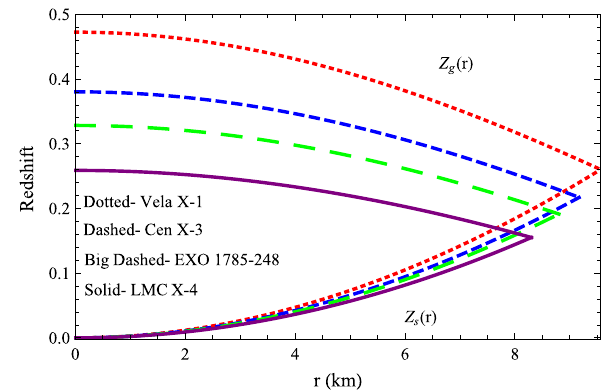
Fig. 6 Functions ρ( r ) − p r ( r ) , ρ( r ) − p t ( r ) and ρ( r ) − p r ( r ) − 2 p t ( r ) vstheradialcoordinate r correspondingtonumericalvaluesofconstants given in Table 2 for four well-known compact stars